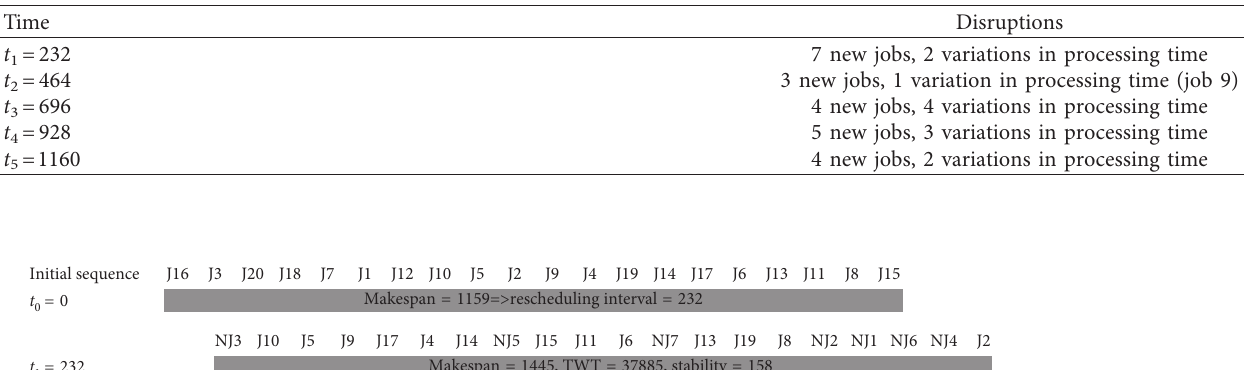
Table 3: Disruptions in TA_20_5_3.